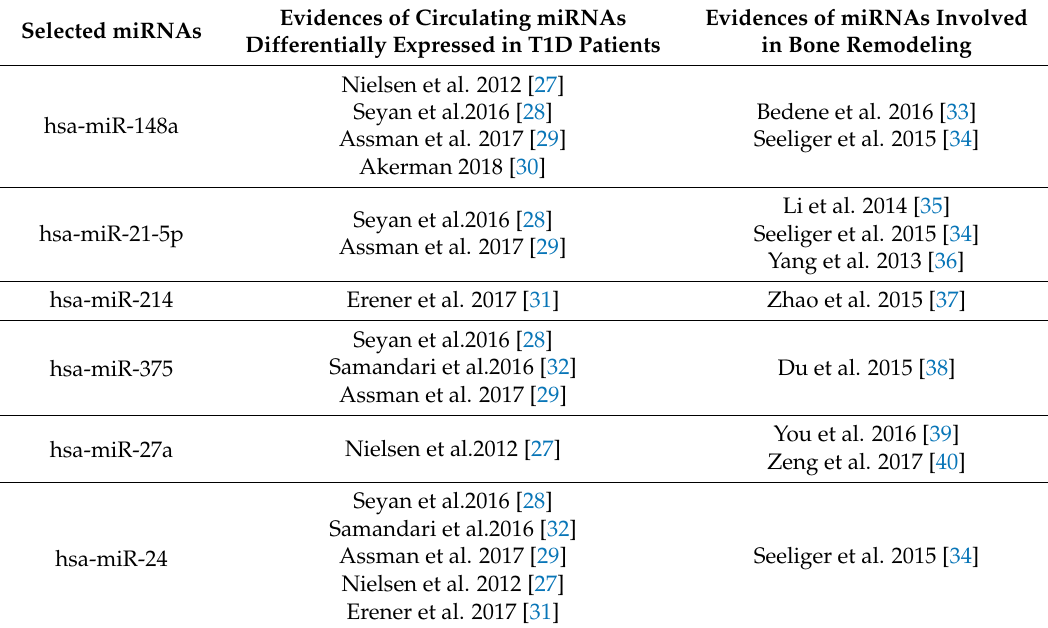
Table 1. Selected miRNAs analyzed in the